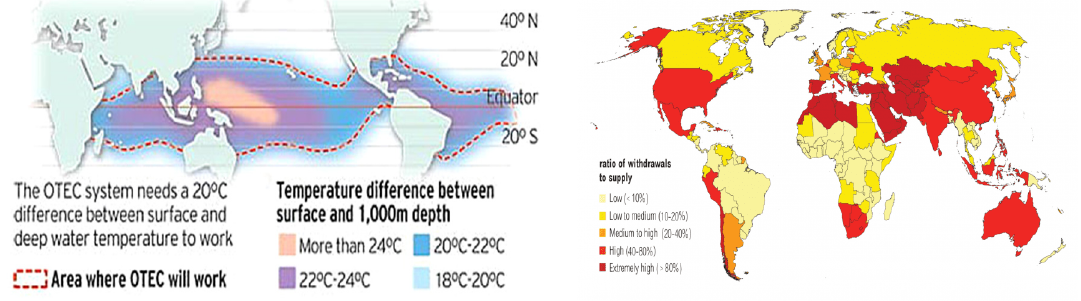
Figure 1. Distribution of world surface sea temperature ( left ) and water stress by country in 2040 ( right ). (Source: INHABITAT & World Resources Institute)